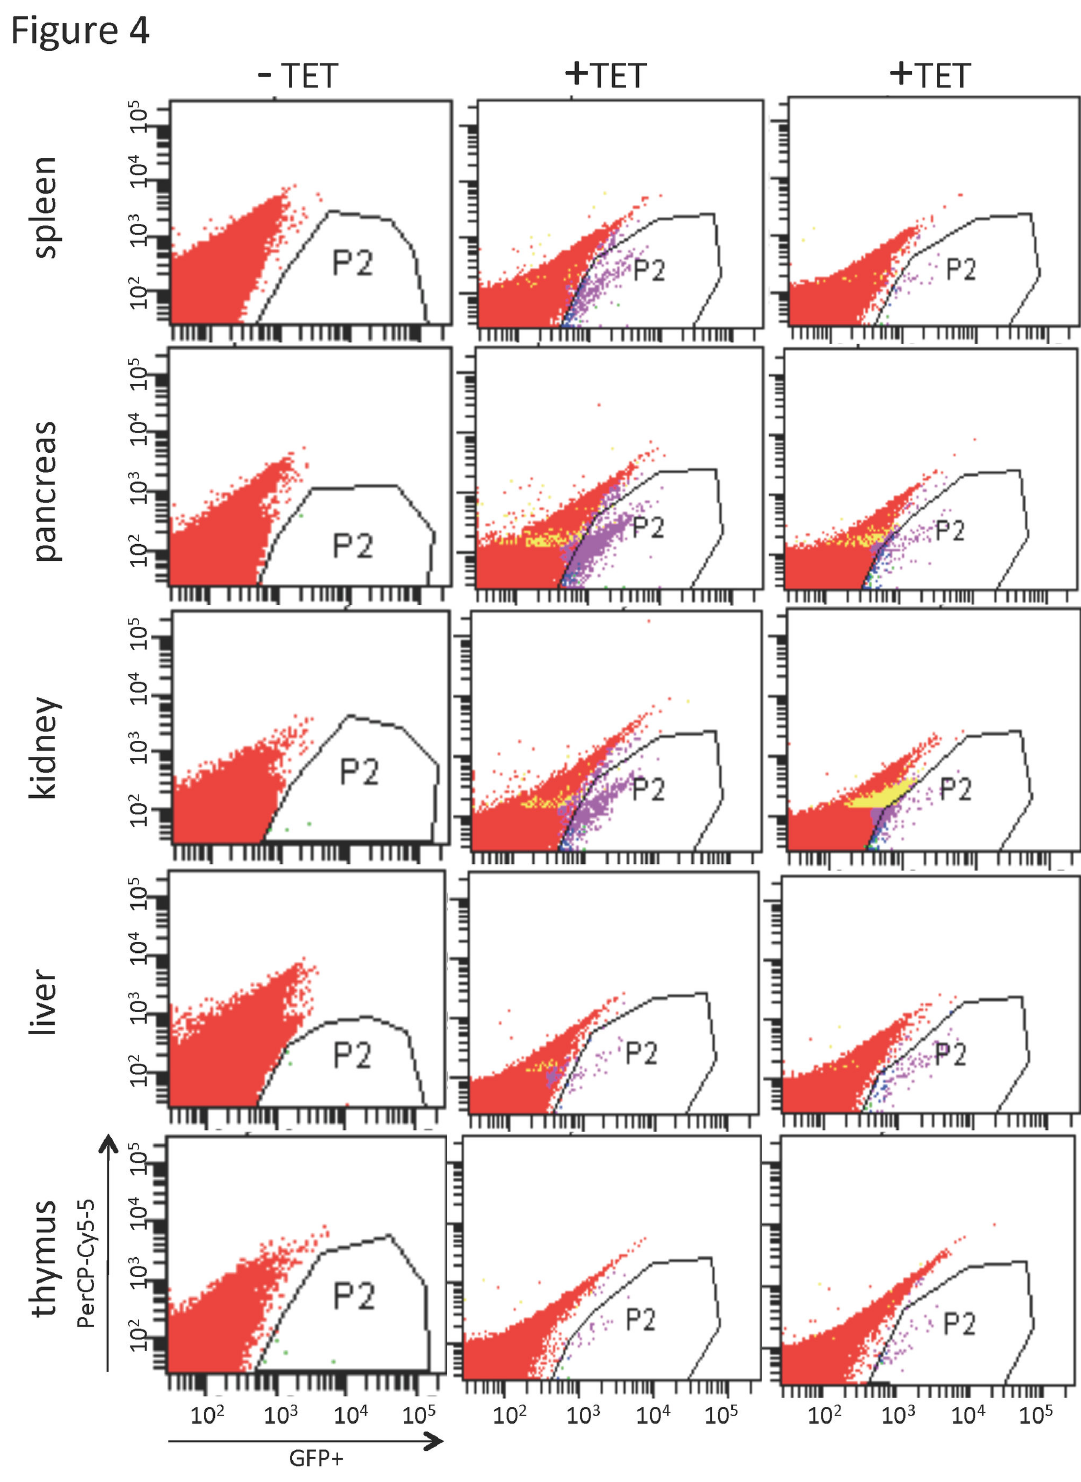
Figure 4. Representative FACS analysis plots of three GS mice for spleen, pancreas, kidney, liver, and thymus. GFP positivity is shown on log scale on the X axis plotted against nonspecific PerCP-Cy5-5 on the Y axis to visualize individual cells. Age-matched negative control mice were not provided TET (-TET). Two representative age-matched mice contain all 3 transgenes and were provided TET as described in text (+TET). Establishment of gates is described in text. doi: 10.1371/journal.pone.0084379.g004 PLOS ONE |